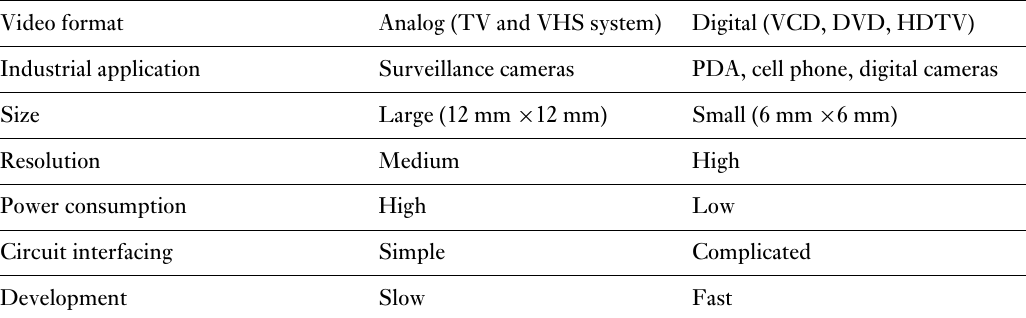
Table 1 Comparison of analog and digital video cameras a